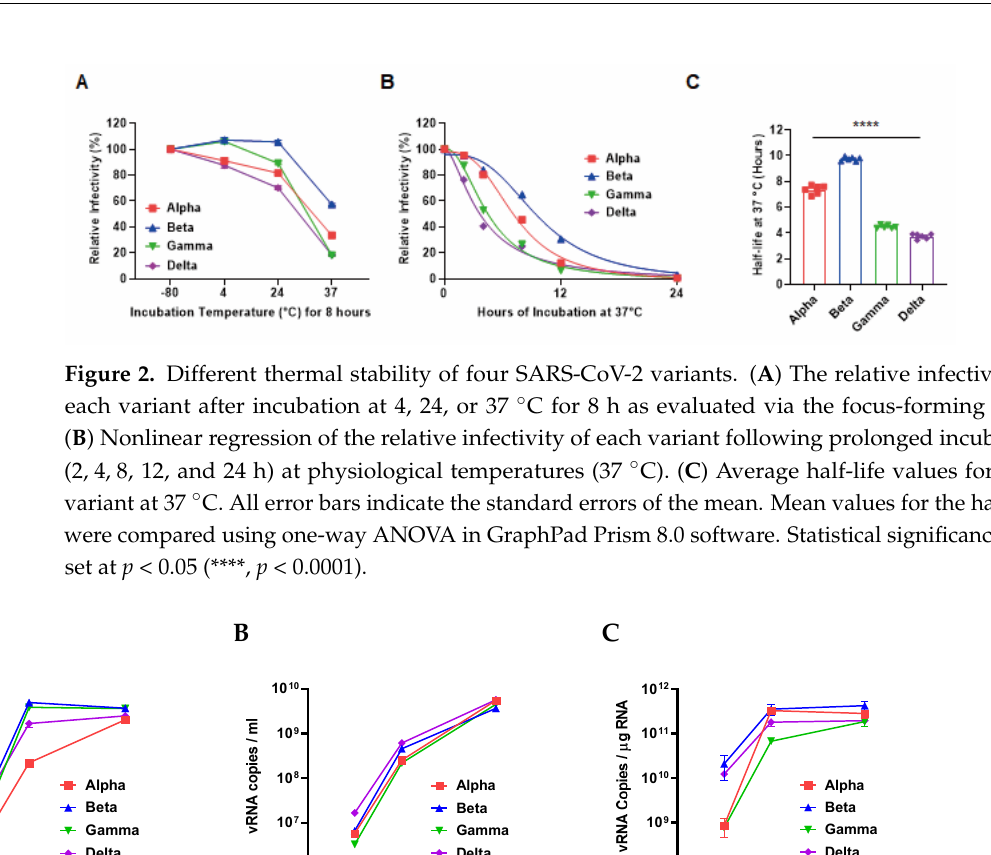
Figure 3. Viral replication rate of four SARS-CoV-2 variants. ( A ) The infectivity of the progeny vi- ruses was evaluated via plaque forming assay completed at 12, 24, and 48 h post infection. ( B ) Ex- tracellular and ( C ) intracellular viral RNA were assessed by qRT-PCR with SARS-CoV-2 NP probes. All error bars indicate the standard errors of the mean.